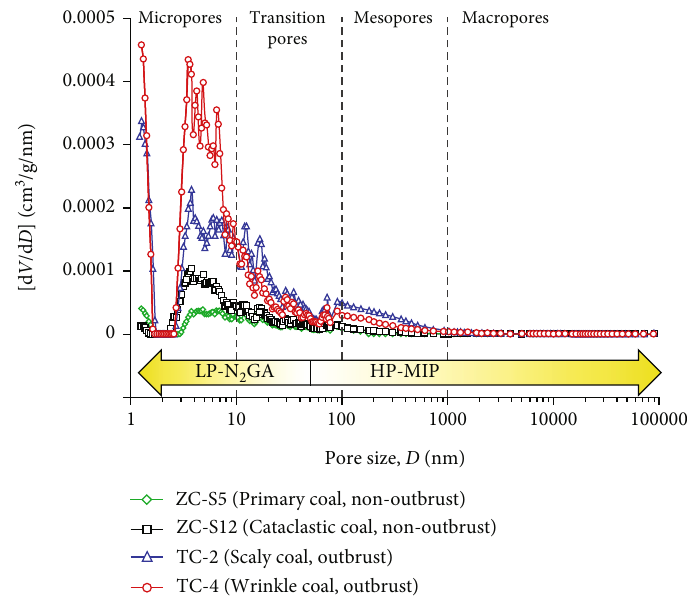
Figure 15: The pore size distribution of the coal samples from HP-MIP and LP-N